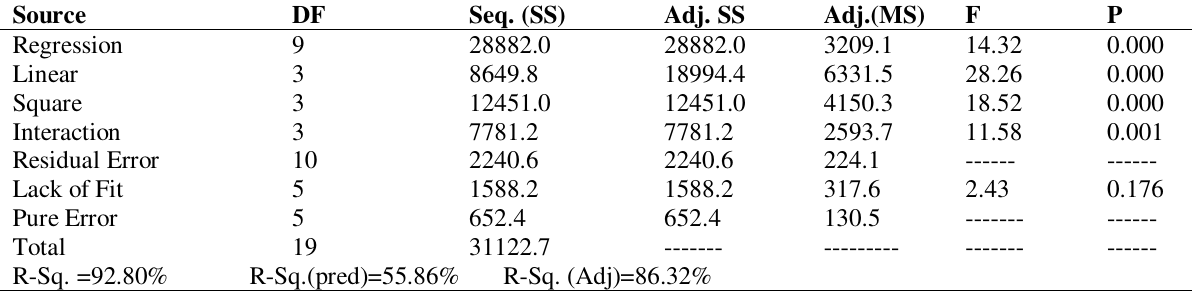
AVONA for bond strength with significant level